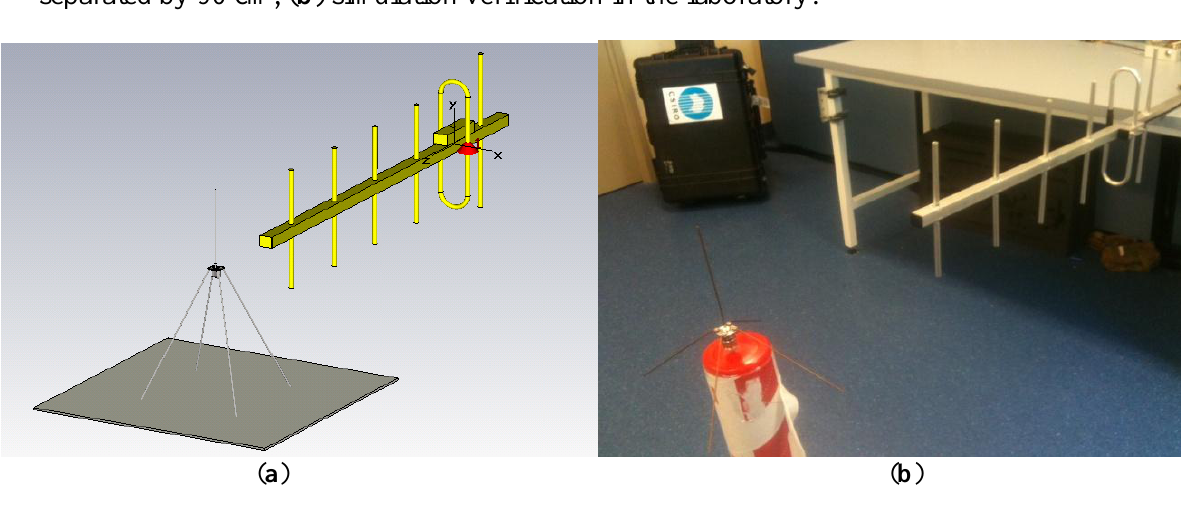
Figure 5. ( a ) The Microwave Studio model of the Yagi antenna and the whip antenna separated by 90 cm; ( b ) simulation verification in the